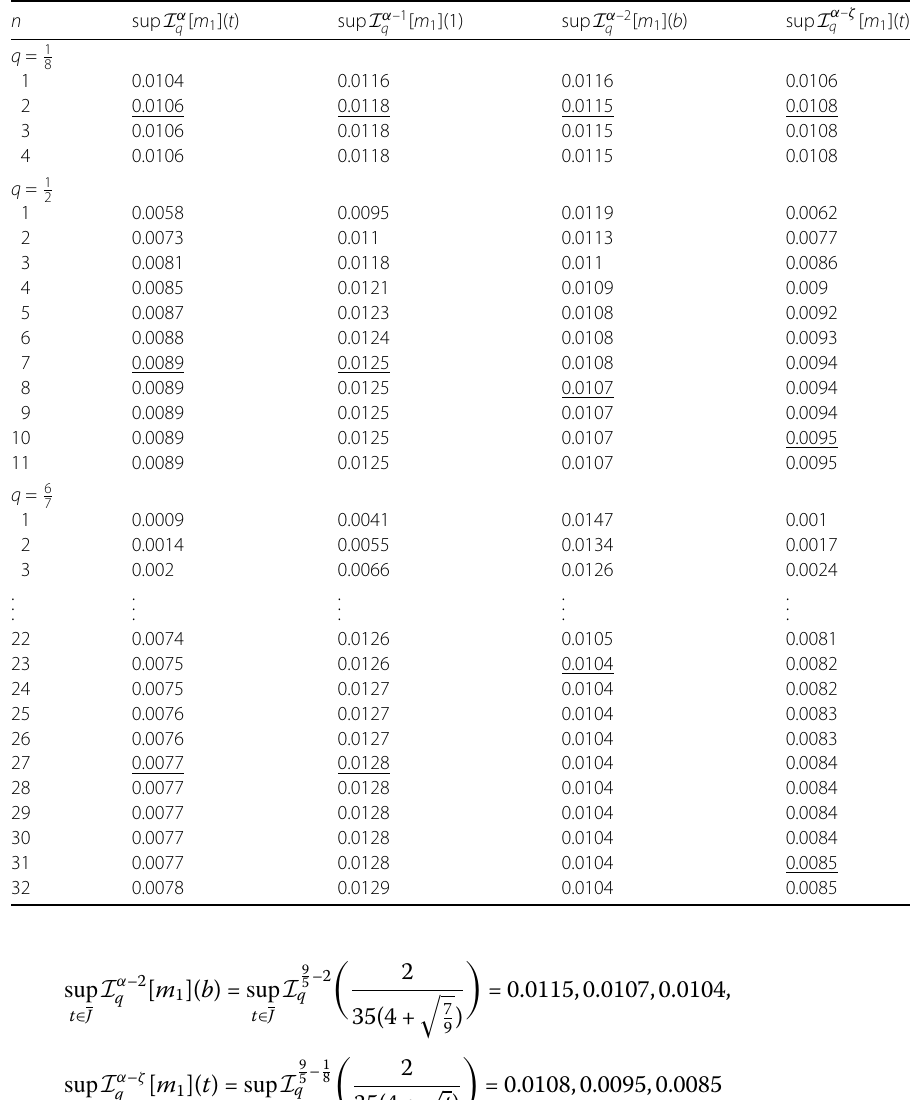
Table 7 Some numerical results of I α q [ m 1 ]( t ), I α –1 q [ m 1 ](1), I α –2 q [ m 1 ]( b ), and I α – ζ q [ m 1 ]( t ) in Example , 1 , 6 2 for t ∈ J and q = 1 8 2